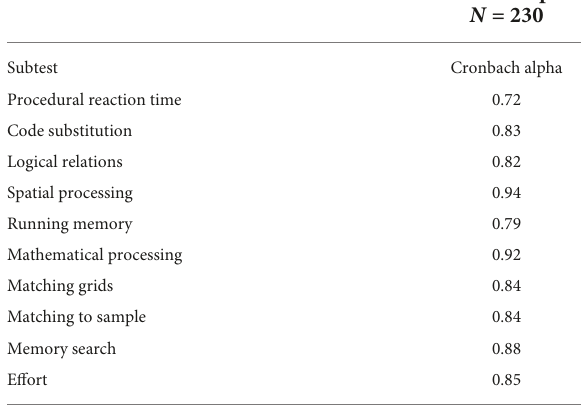
TABLE 8 Correlation between execution speed in each subtest in test-retest evaluation (Pearson